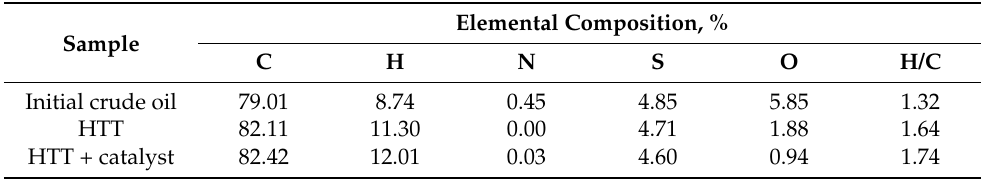
Table 3. Elemental composition of heavy oil samples.